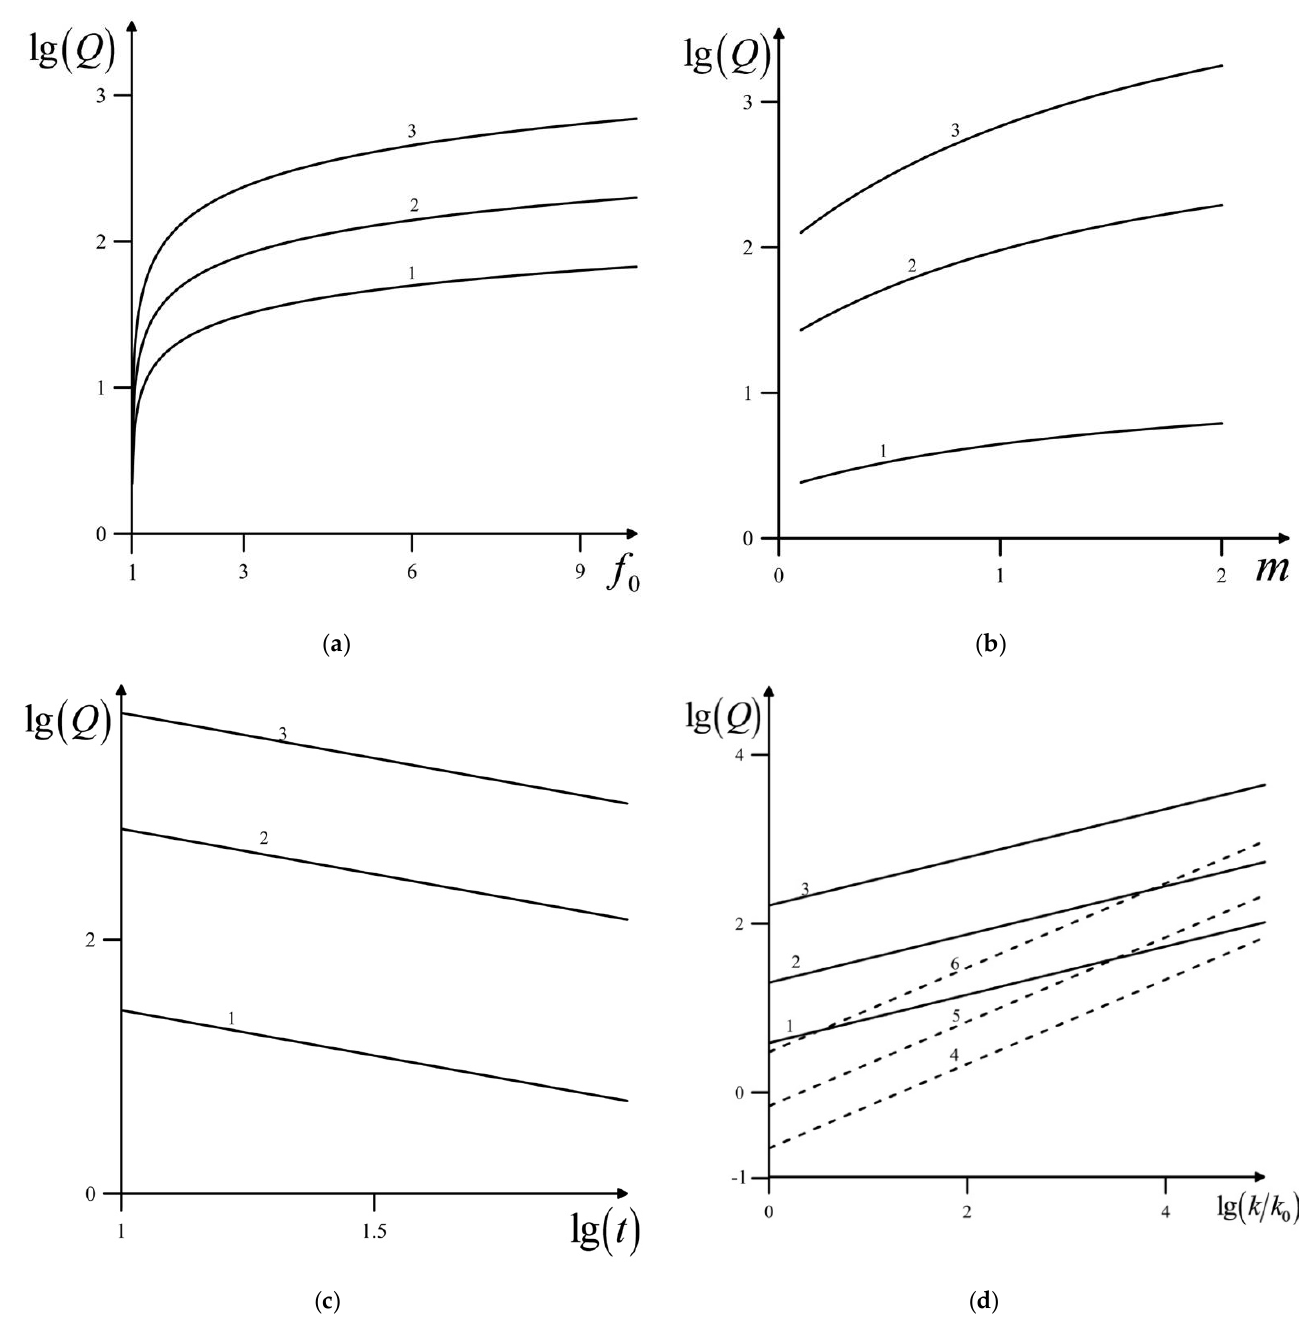
Figure 6. Annual gas flow rate Q [g/m 2 ·year], averaged over 100 − year period, versus: ( a ) normalized latent pressure f 0 = p 0 / p c at m = 0.01; 1; 2 ( 1 − 3 ) ; ( b ) annual gas flow rate versus the permeability exponent m at f 0 = 1.01; 2; 20 ( 1 − 3 ) ; ( c ) annual flow rate changes during 100 − year period at m = 1.5 and f 0 = 1.01; 2; 20 ( 1 − 3 ) ; ( d ) annual flow rate dependence on permeability at k 0 = 10 − 23 m 2 , and f 0 = 1.1; 2; 20 ( 1 − 3 ) . Dashed lines correspond to Darcy’s law, f 0 = 1.1; 2; 20 ( 4 − 6 )